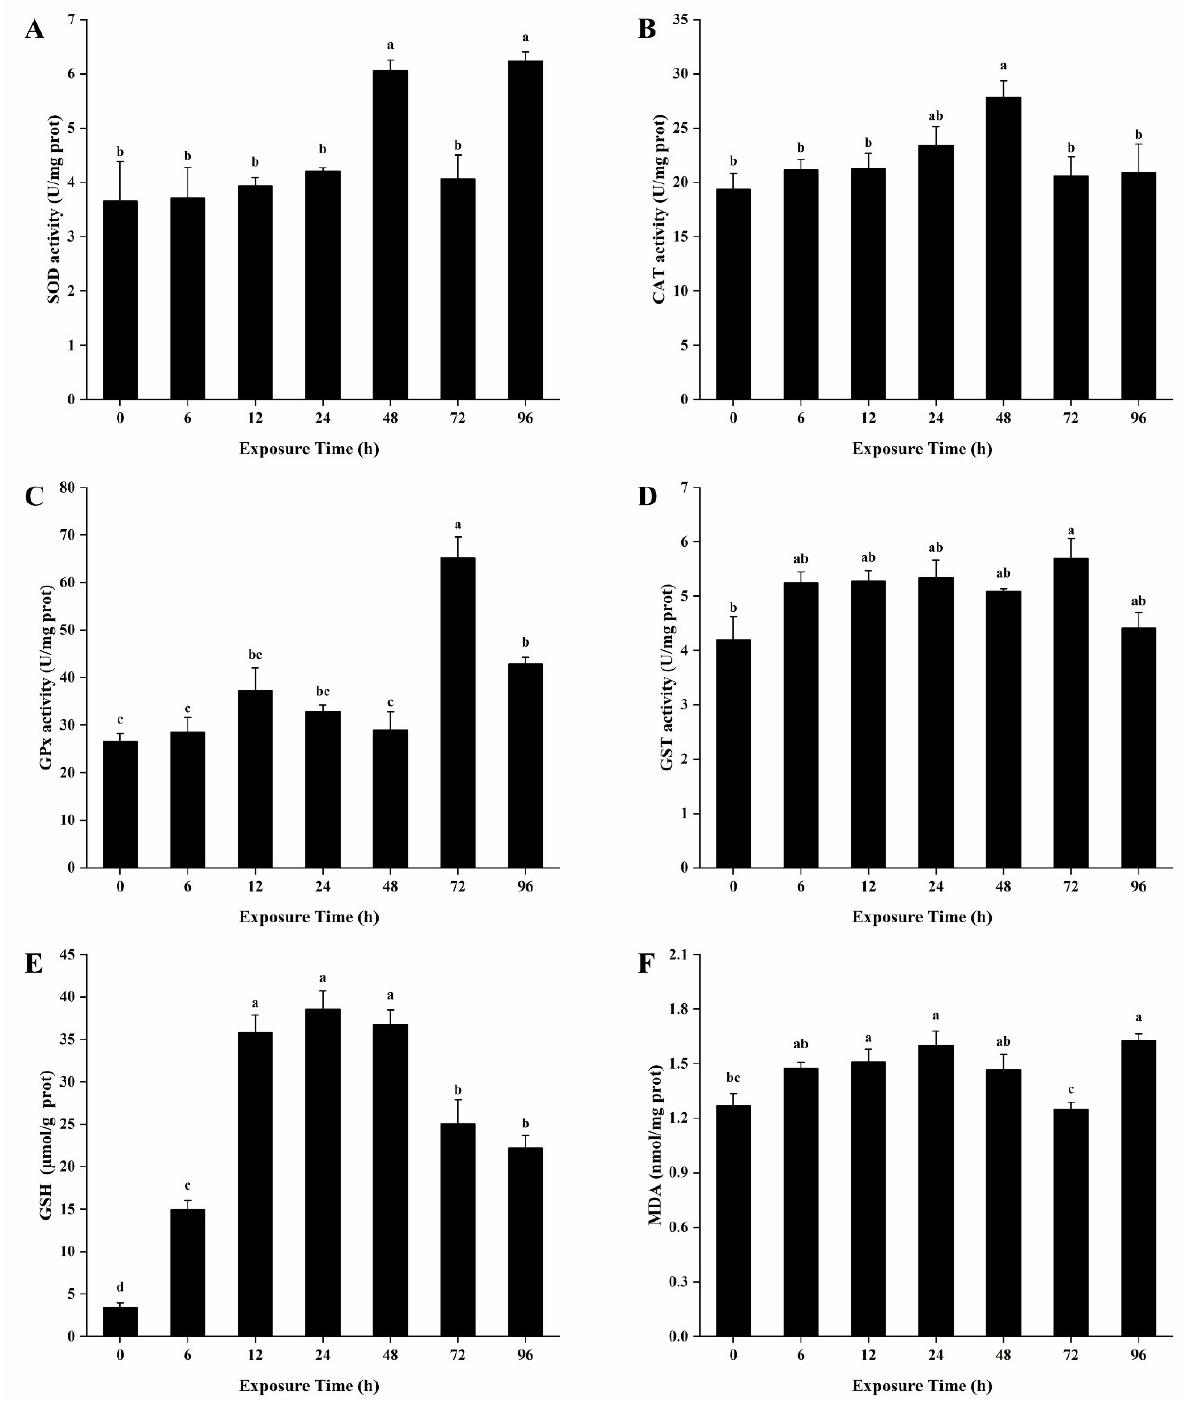
Figure 3. The activities of SOD ( A ), CAT ( B ), Gpx ( C ), and GST( D ) and the contents of GSH ( E ), MDA ( F ) in the gills of H. cumingii exposed to 6.43 mg L − 1 unionized ammonium for 0 (control), 6, 12, 24, 48, 72, and 96 h. Values are presented as the mean ± SE ( n = 6). Superscripted lowercase letters indicate a significant effect of exposure time ( p < 0.05).